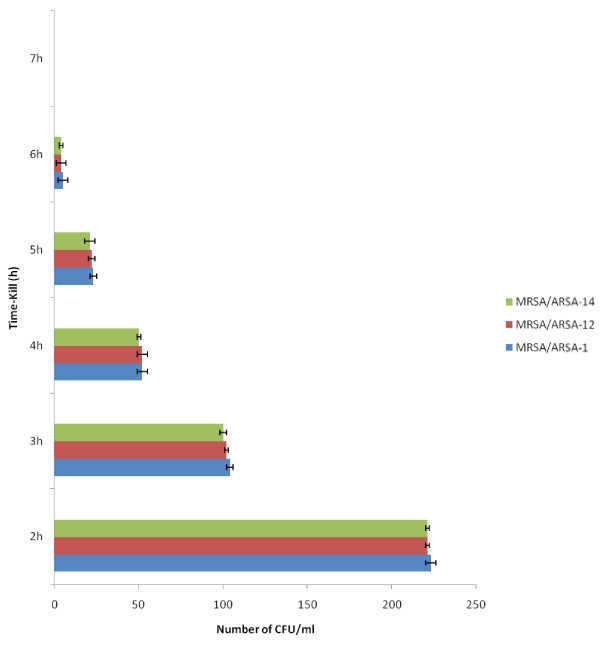
 Viability of microorganisms after 6 hours exposure with Alkaloid compounds fromCienfuegosia digitataCav. Absence of colonies after 6 h. CFU uncountable before 2 h. The results are the means of number of the colonies ± standard deviations.